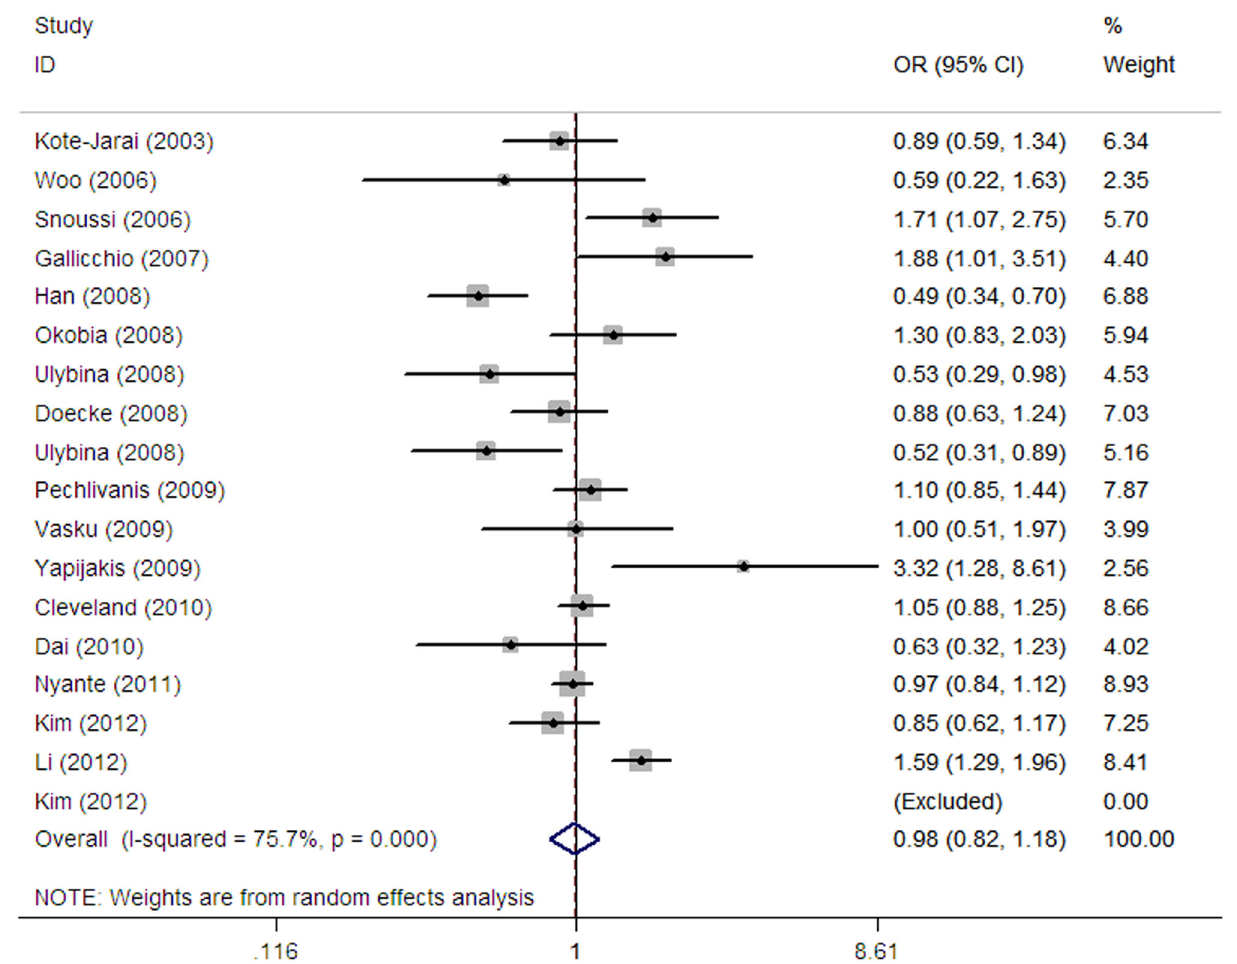
Figure 4. Forest plot for the LEPR Q223R polymorphism (recessive model).